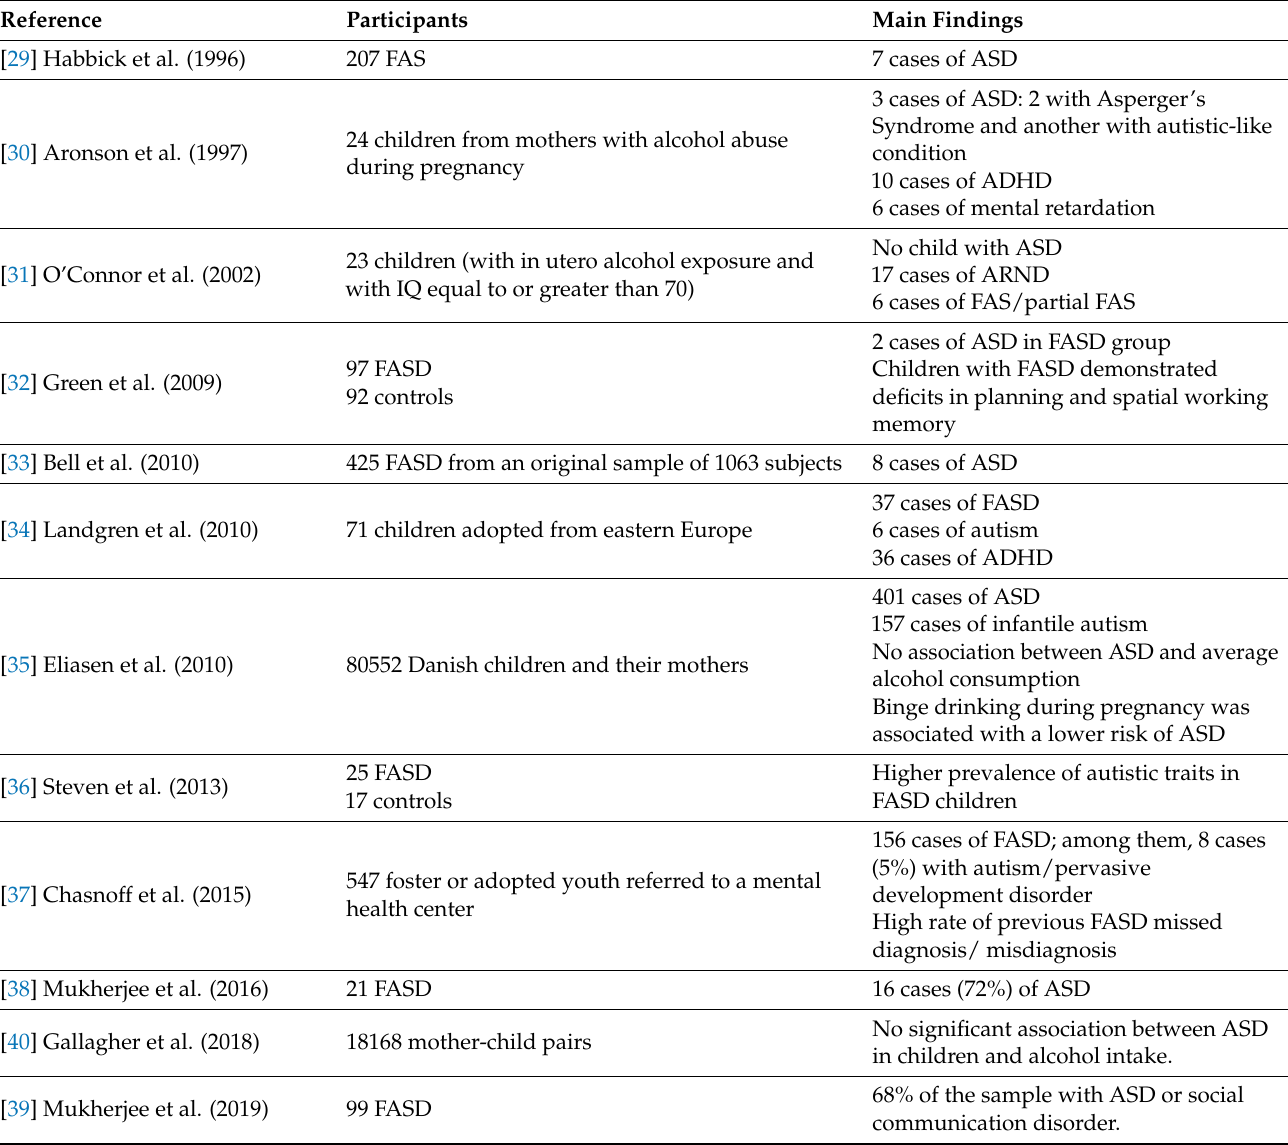
Table 2. Studies on the prevalence of ASD diagnosis in children with different levels of alcohol prenatal exposure or